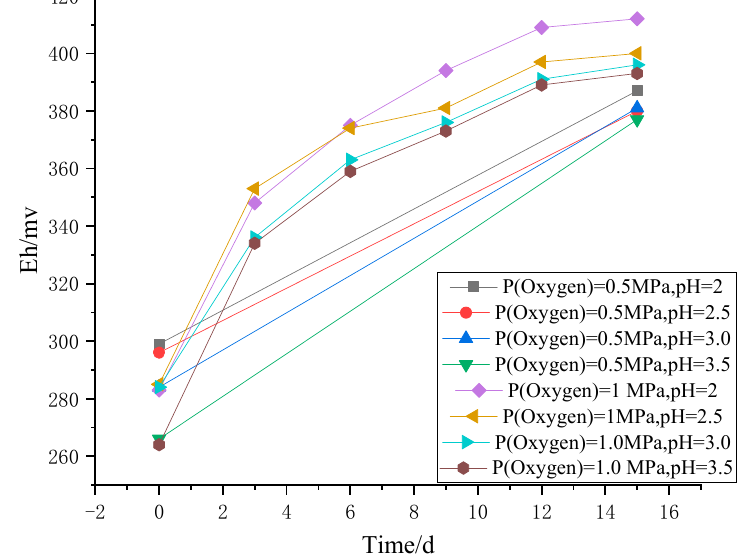
Figure 8. Variation in oxygen as oxidant Eh with time ( c (Fe(II)) is 2 g/L).